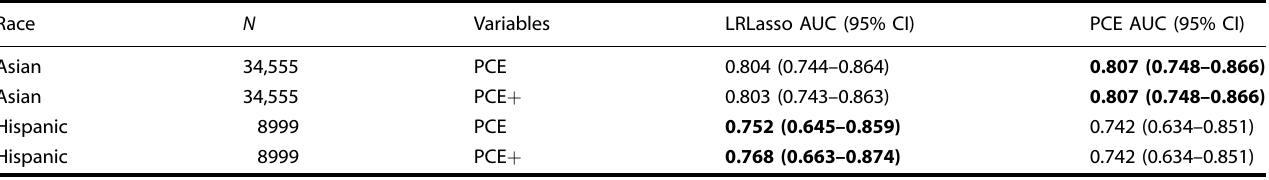
Table 2. AUCs for Asian and Hispanic patients without missing PCE variables.